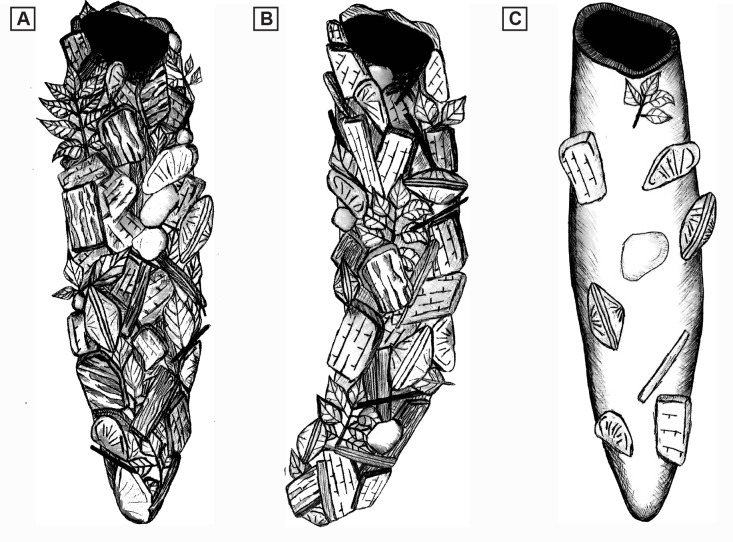
Caddisfly case reconstruction.(A) Straight caddisfly case. (B) Curved J-shaped caddisfly case. (C) Straight caddisfly case. Cases are lined with plant fragments, ostracod valves, mica, and carbonate rock fragments. Note: Caddisfly case particles are for illustration purpose, not to scale.